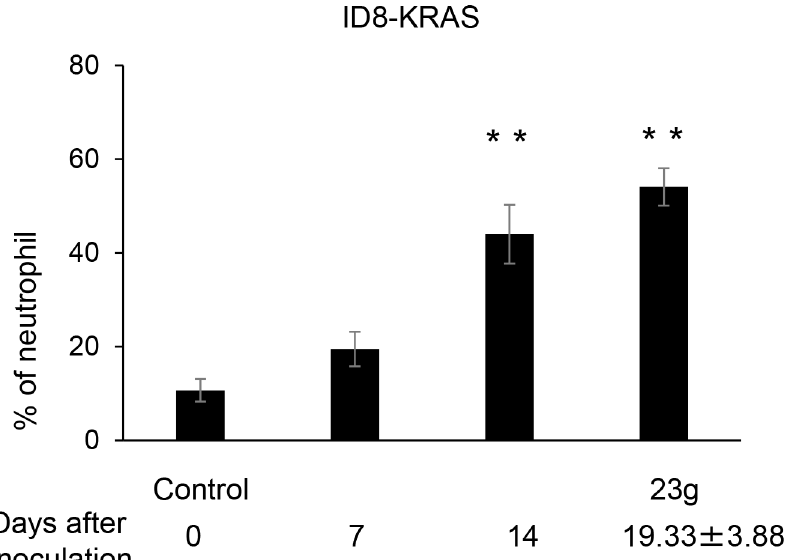
Fig 5. Time course analysis of neutrophil counts. ID8-KRAS cells (2 × 10 6 ) were injected into the peritoneal cavities of C57/BL6 mice. ID8-KRAS mice were sacrificed on day 7(n = 6), and day 14(n = 8), and the day BW reached 23 g (n = 6). Six C57/BL6 mice were sacrificed as control. Neutrophils were stained with the following antibodies: FITC-anti-mouse CD45, APC-anti-mouse Ly6G. Dunnett's test was used to find the statistical significance compared to the control group ( ** P (cid:1)